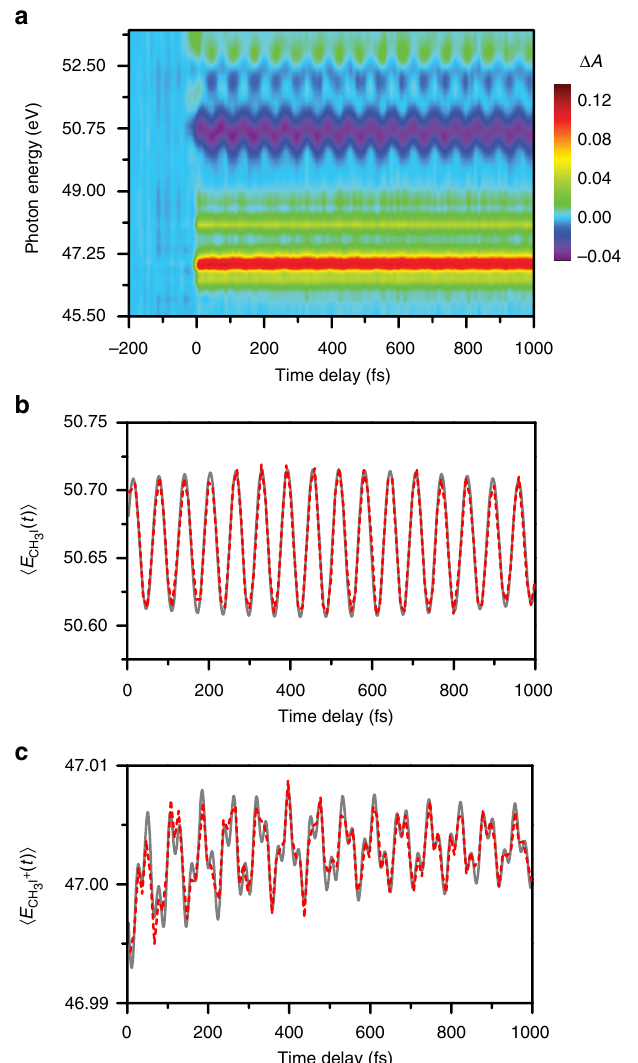
Fig. 2 I 4 d transient absorption spectra of stong- fi eld-ionized CH 3 I. a Contour plot of the differential XUV absorption spectra collected as a function of pump-probe time delay. Time-resolved spectral fi rst-moments calculated about the b neutral CH 3 I I 4 d j ! σ (cid:2) resonance, h E CH t ð Þi ; and C (cid:3) I 3 I the c CH 3 I + I 4 d 5 = 2 ! e (cid:3) 1 resonance, h E CH t ð Þi ; are also shown. The 3 = 2 3 I þ dashed red lines are the data and the solid gray lines are obtained from fi ts